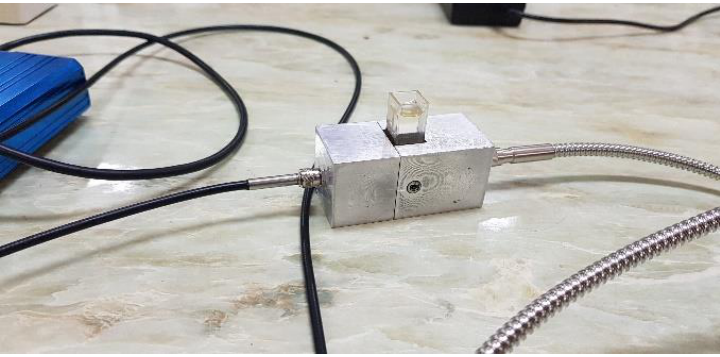
Figure 2. Measurement of VIS/near infrared (NIR) spectra of pesticide in passing mode.